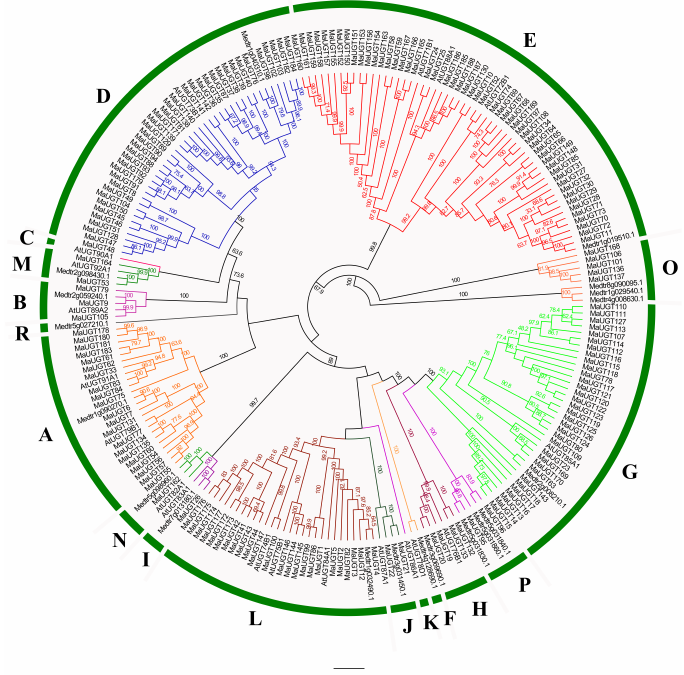
Figure 1. Phylogenetic analysis of the UGTs from M. albus . A total of 189 UGT proteins from M. albus , 19 UGTs from Arabidopsis, and 19 UGTs from M. truncatula were used to construct the neighbor-joining tree using the program MEGA 7.0. All protein sequences were full length, and the bootstrap values of 1000 replicates were calculated at each